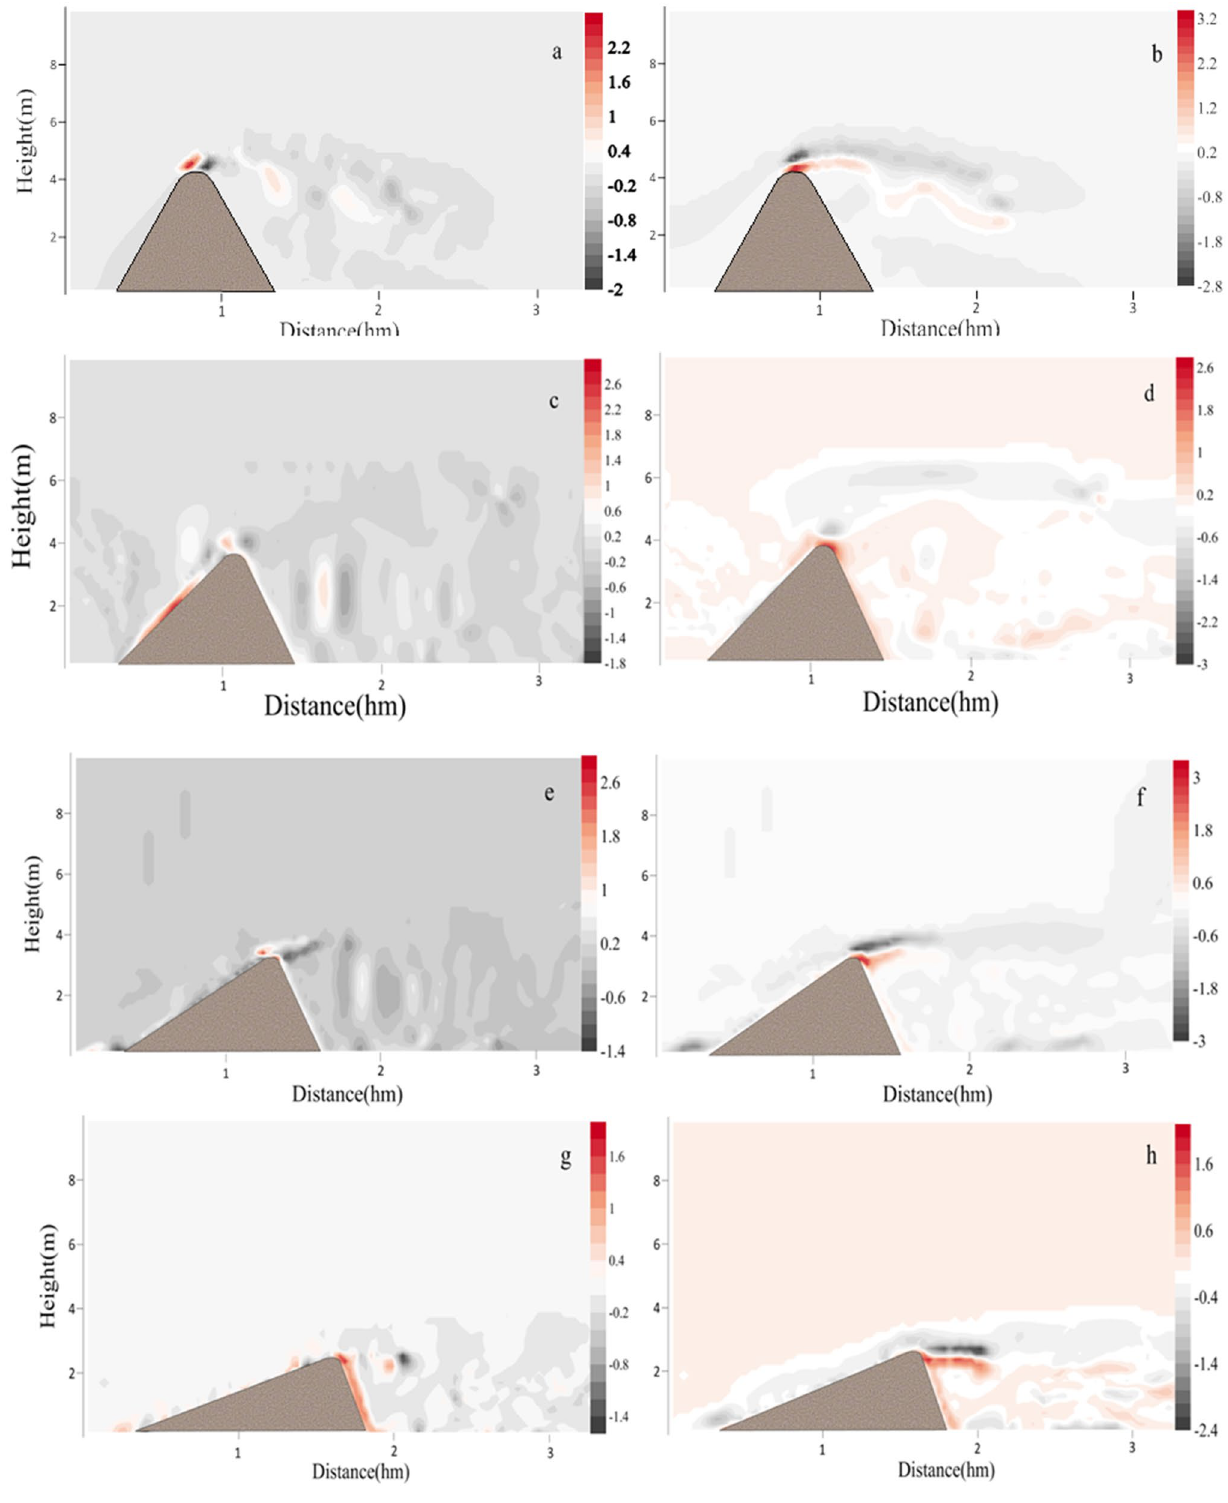
Figure 5. The horizontal ( a , c , e , g ) and vertical ( b , d , f , h ) components of spatial sand flux at different stages in Fig.